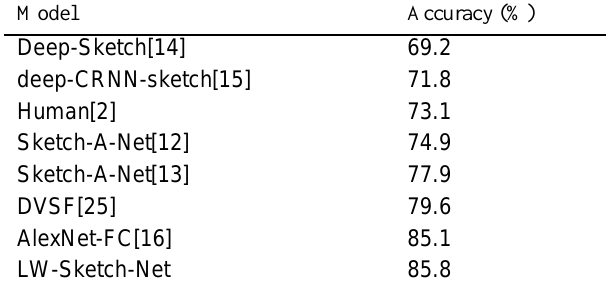
Table 7. Recognition accuracy on TU-Berlin